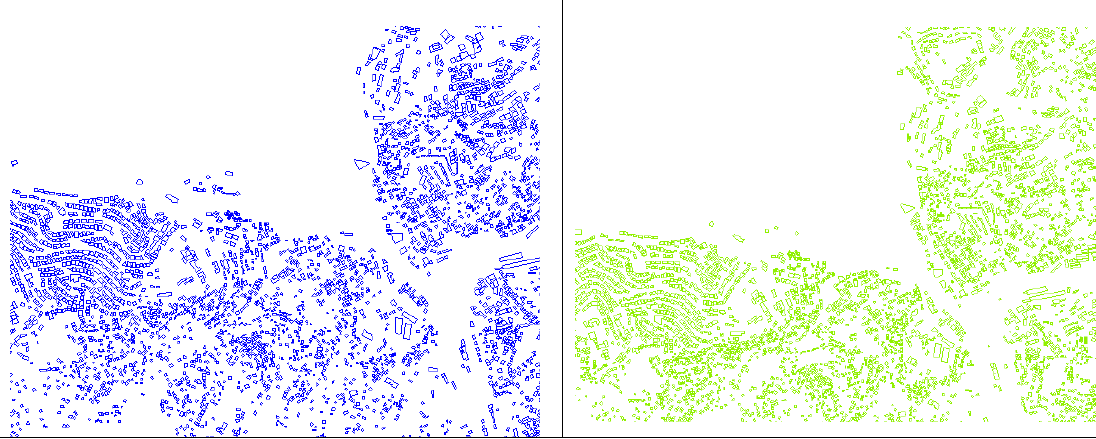
Figure 6. GIS Based analysis of on-screen manual digitizing results of the building from IKONOS-2008 image (left) and reference vector